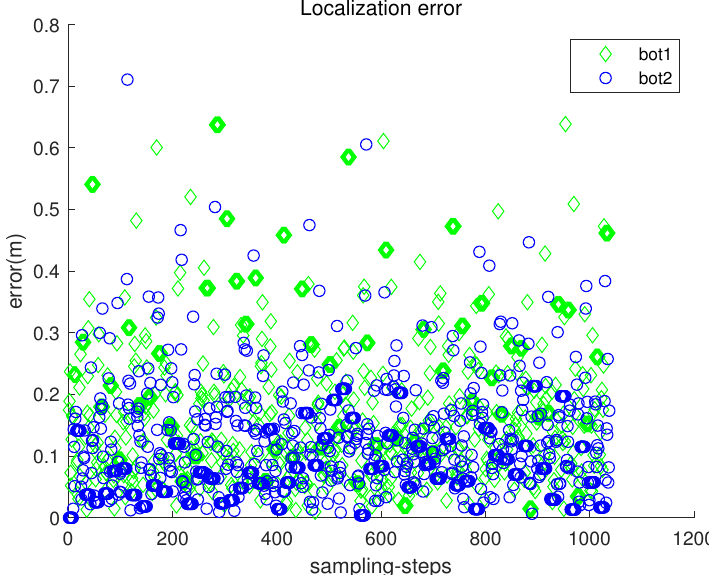
Figure 11. Scenario 2. The localization error (cid:107) r i ( k ) − ˆ r i ( k ) (cid:107) with respect to sampling-stamp k .